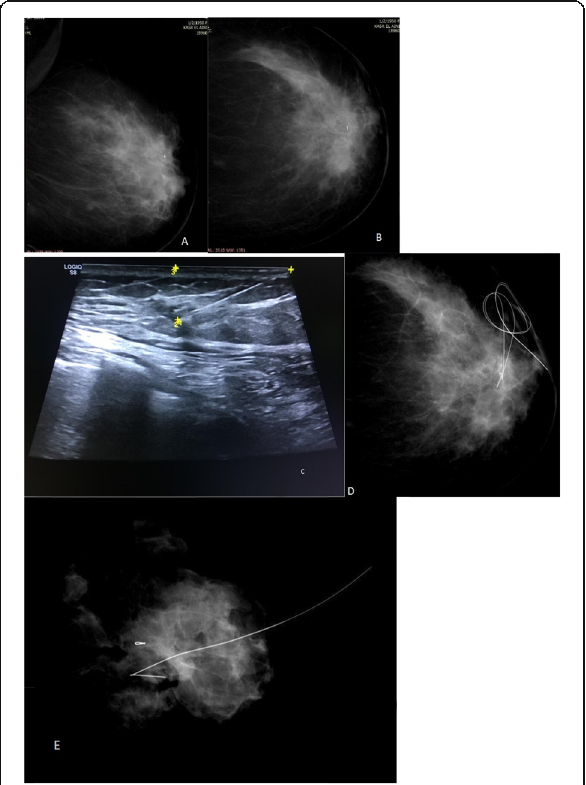
Fig. 7 A 53-year-old female presented with left breast lump proved to be IDC grade III. Left breast MLO a and CC b view show UOQ